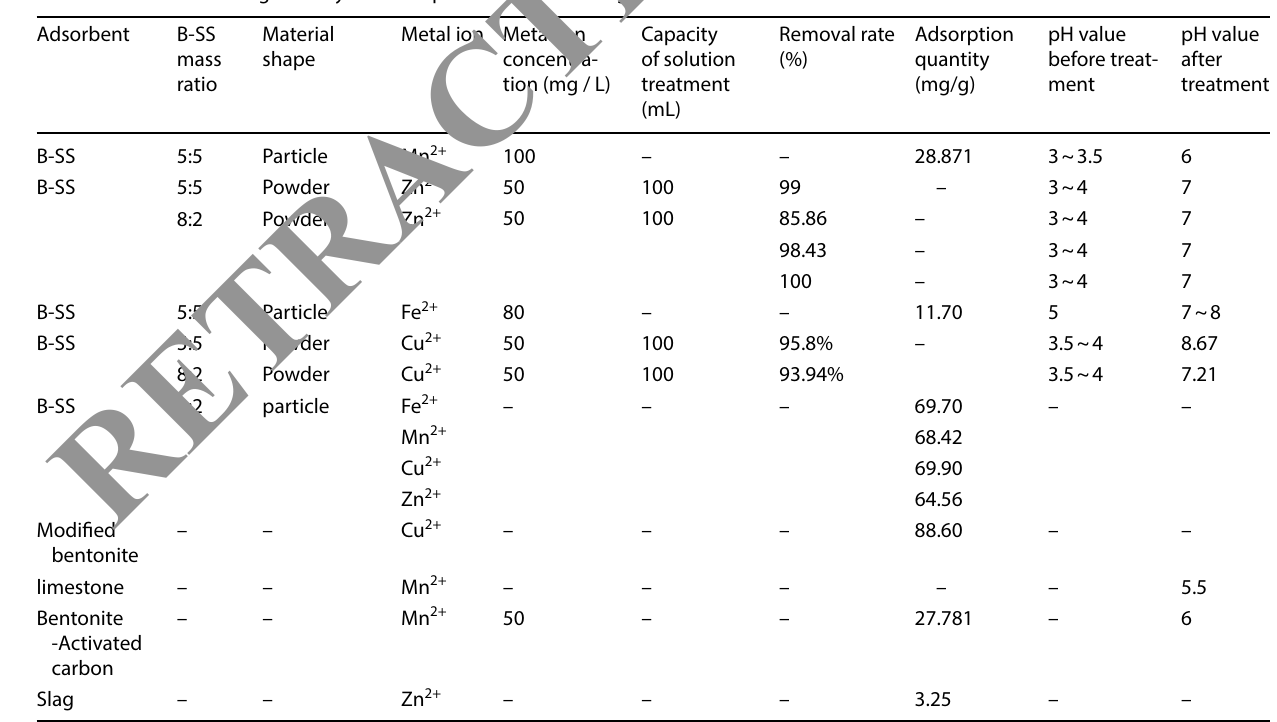
Table 6 Results of treating AMD by B-SS composites and some single modified adsorbent